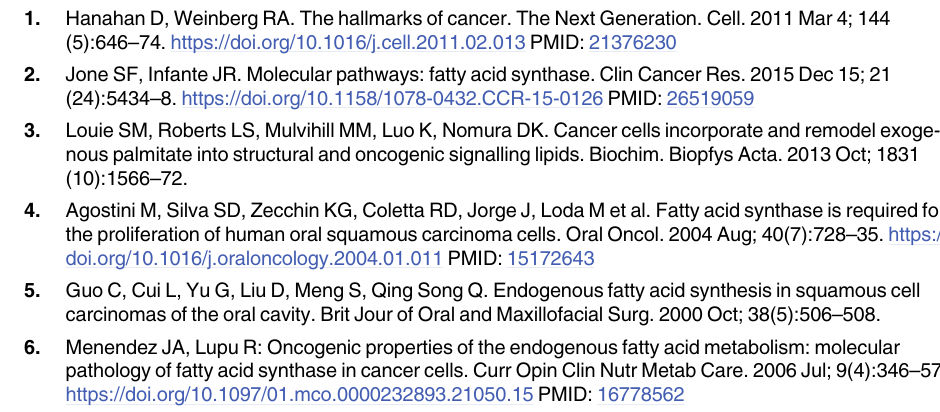
S3 Table. Ratio of percentage content of particular FAs in tumor/ATME, ATME/serum and in tumor/serum vs. tumor